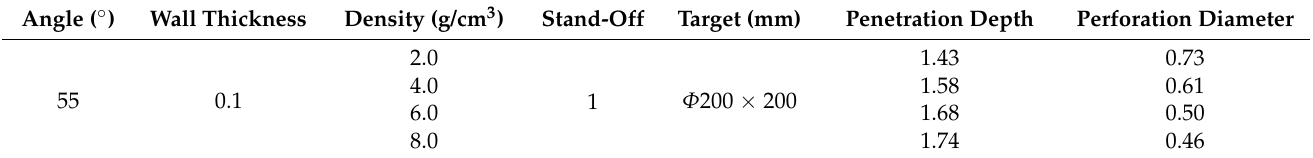
Table 4. Experimental results of steel target with different density of reactive charge liner (CD).